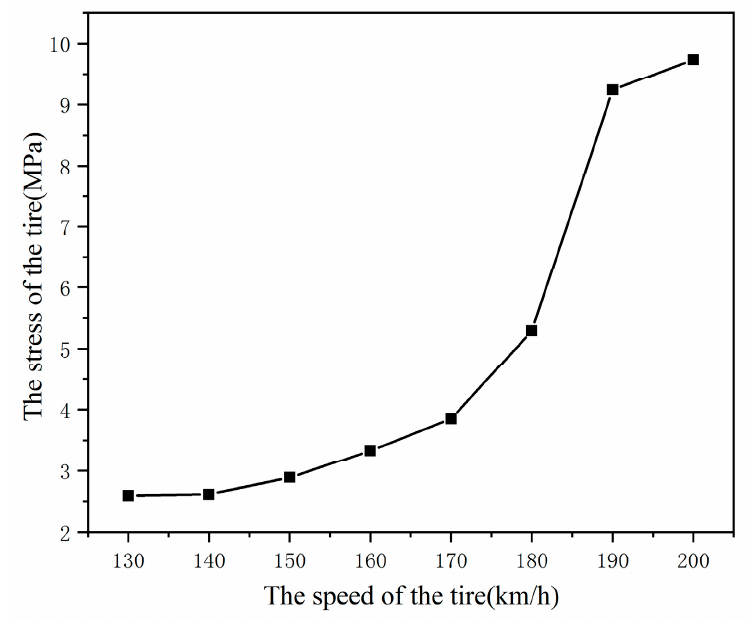
Figure 12. Stress field of aircraft tire at different speeds: ( a ) 130 km/h, ( b ) 150 km/h, ( c ) 170 km/h, ( d ) 190 km/h.